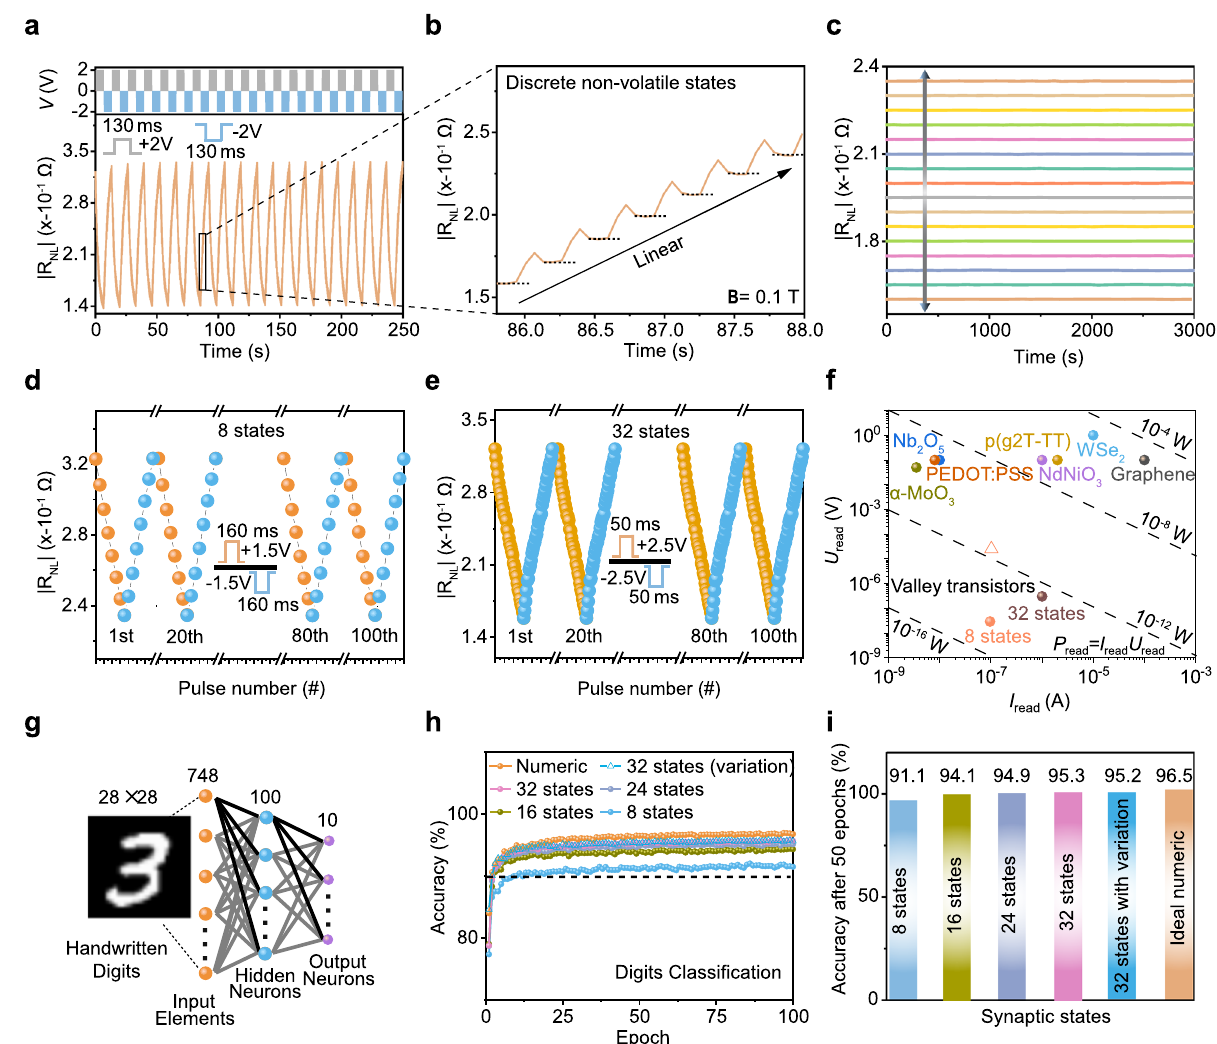
Fig. 5 | Synaptic valley transistors with linear and long-term memory char- with d 8 and e 32 stable states under the applied constant current of 100nA and acteristics for neuromorphic computing. a Potentiation and depression states 1 μ A, respectively. f Readout current and voltage in our valley transistors and reported works. The dash lines are corresponding from 10 − 16 to 10 − 8 W. g Arti fi cial under the control of voltage pulses with the solid-state electrolyte PEO/LiClO 4 . E V neuralnetworkforclassifyinghandwrittendigits.Thelinearandstablevalleystates g =+2VisappliedtoadsorbandintercalateLi + intoTeandmove F awayfromthe Weyl point. V g = − 2V is applied to relax and extract Li + and move E F back. The test are used for the connected synapses between neurons. Inset shows a three-layer temperature is 300K under B =0.1T. b A zoomed-in view of a with multiple linear arti fi cial neural network for classifying handwritten digits in the MNIST database. h Neuromorphic classi fi cation based on the non-volatile valley transistors. The states. The dash lines indicate the stable states. c Stable valley states under reten- tion tests of 3000s. V g >0 for reducing the valley resistance and V g <0 for black dash line corresponds to the 90% recognition accuracy. i Classi fi cation increasing the valley resistance. d , e Cycle-to-cycle performanceof valley synapses accuracy after 50 epochs for different non-volatile states and ideal